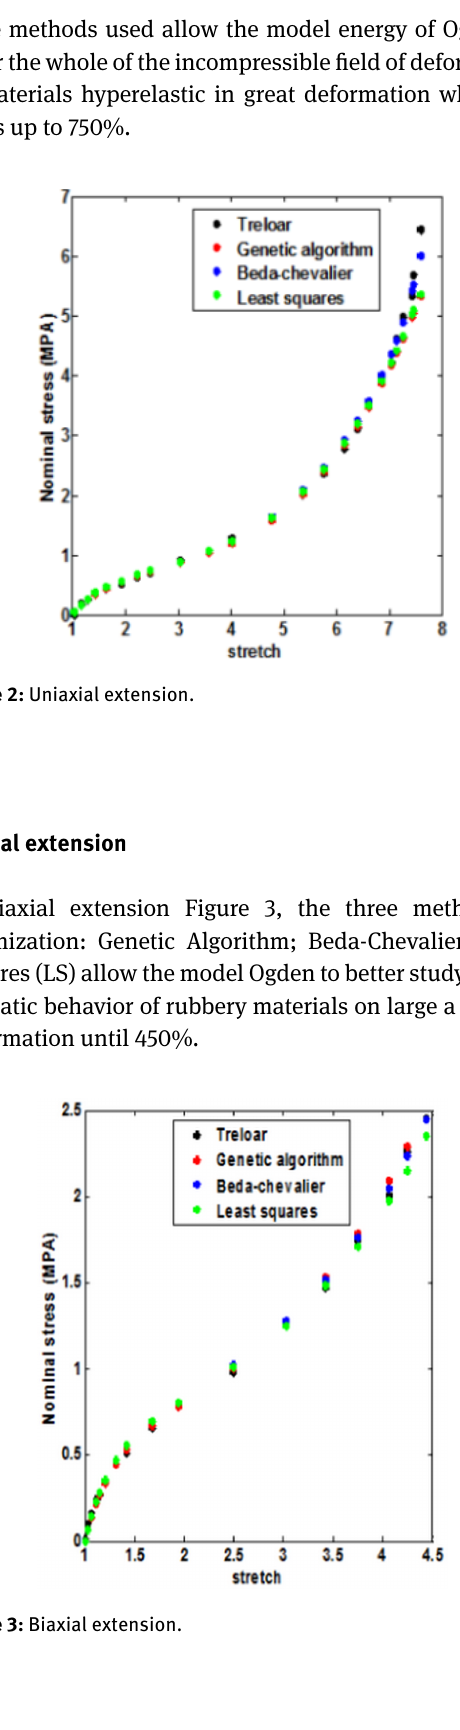
Table 1: Parameters Values.